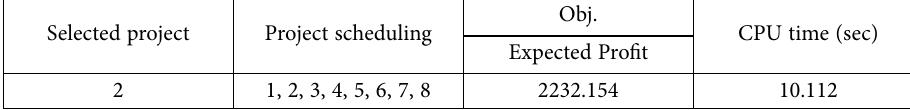
Table 2. The result of the first scenario Selected project